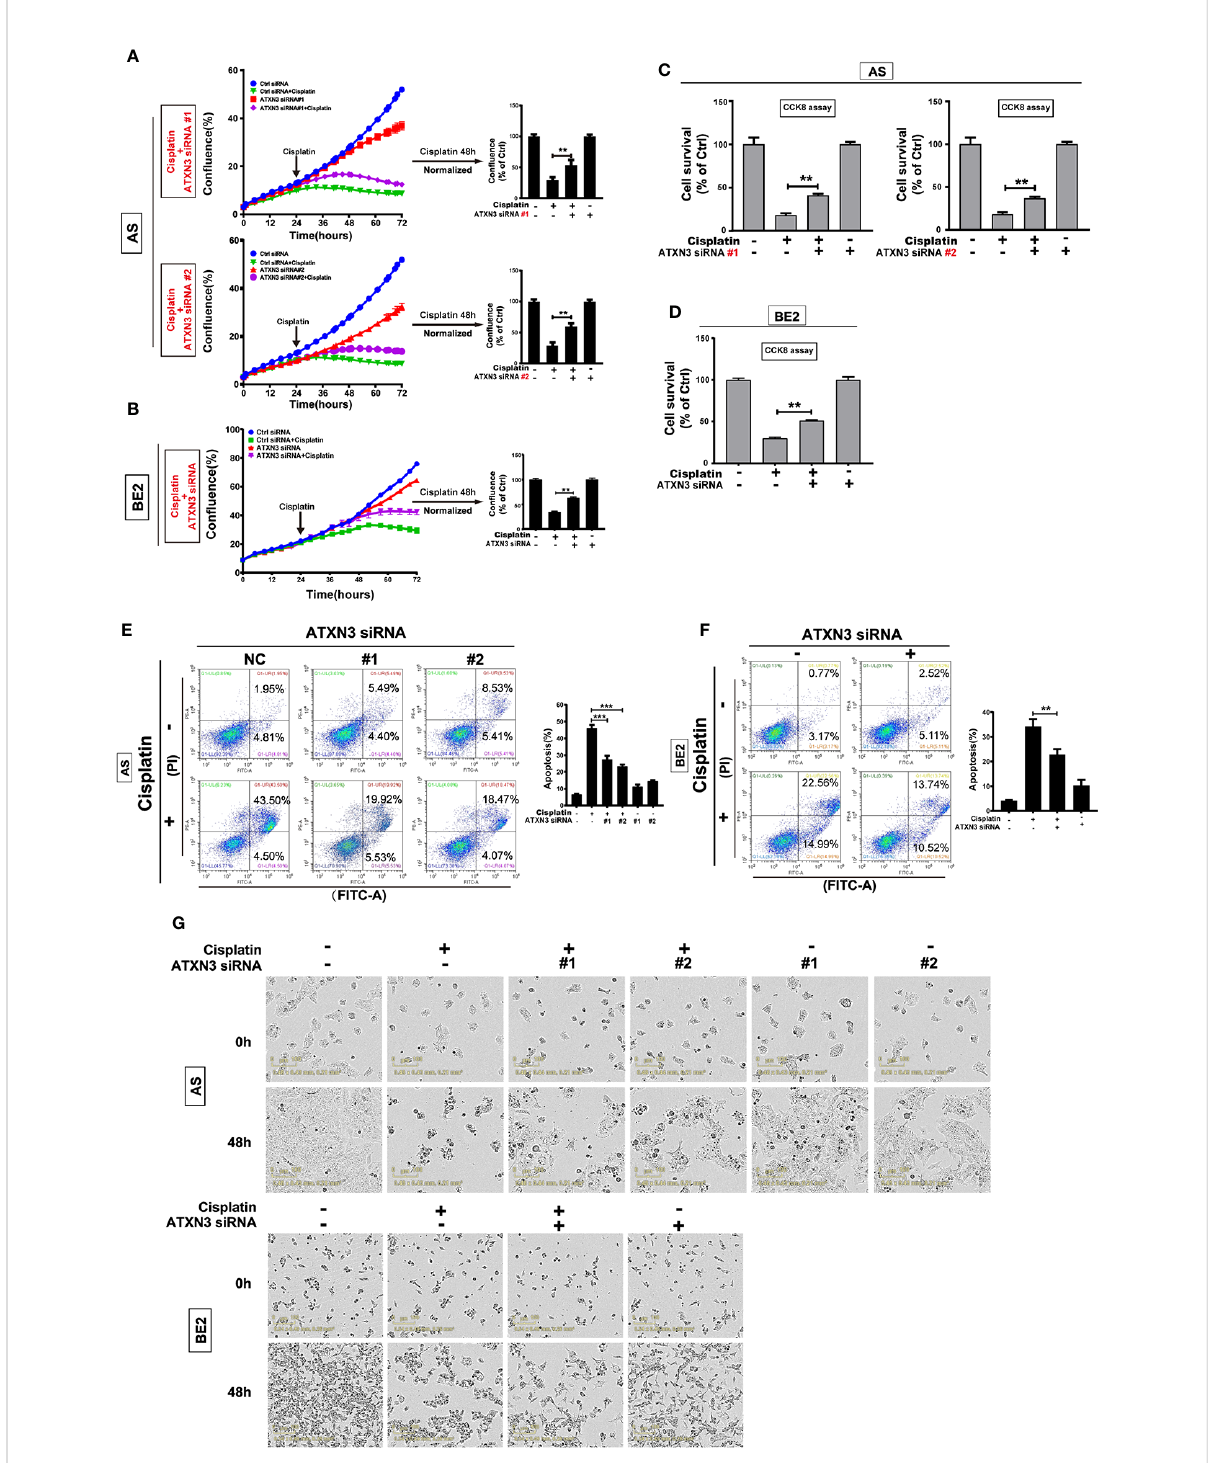
FIGURE 5 Downregulation of ATXN3 decreased the sensitivity of NB cells to cisplatin. AS cells were transfected with ATXN3 siRNAs (#1, #2) and BE2 cells were transfected with ATXN3 siRNA #2 (marked as ATXN3 siRNA) for 16 h, followed by 48 h treatment of cisplatin. (A, B) Cell con fl uence was dynamically detected and analyzed by IncuCyte Zoom; (C, D) Cell survival was detected by CCK8 assay; (E, F) Cell apoptosis was detected by Annexin V/PI fl ow cytometry; (G) The images of AS and BE2 cells with ATXN3 siRNAs transfection and cisplatin treatment at 0 h and 48 h were recorded. Bar, SD, ***, P<0.01, **, P<0.01, ATXN3 siRNAs + cisplatin vs. control siRNA +